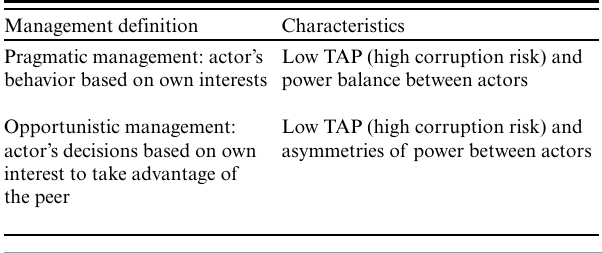
Table 2 . Management practices and transparency, accountability, and participation (TAP)-power characteristics.